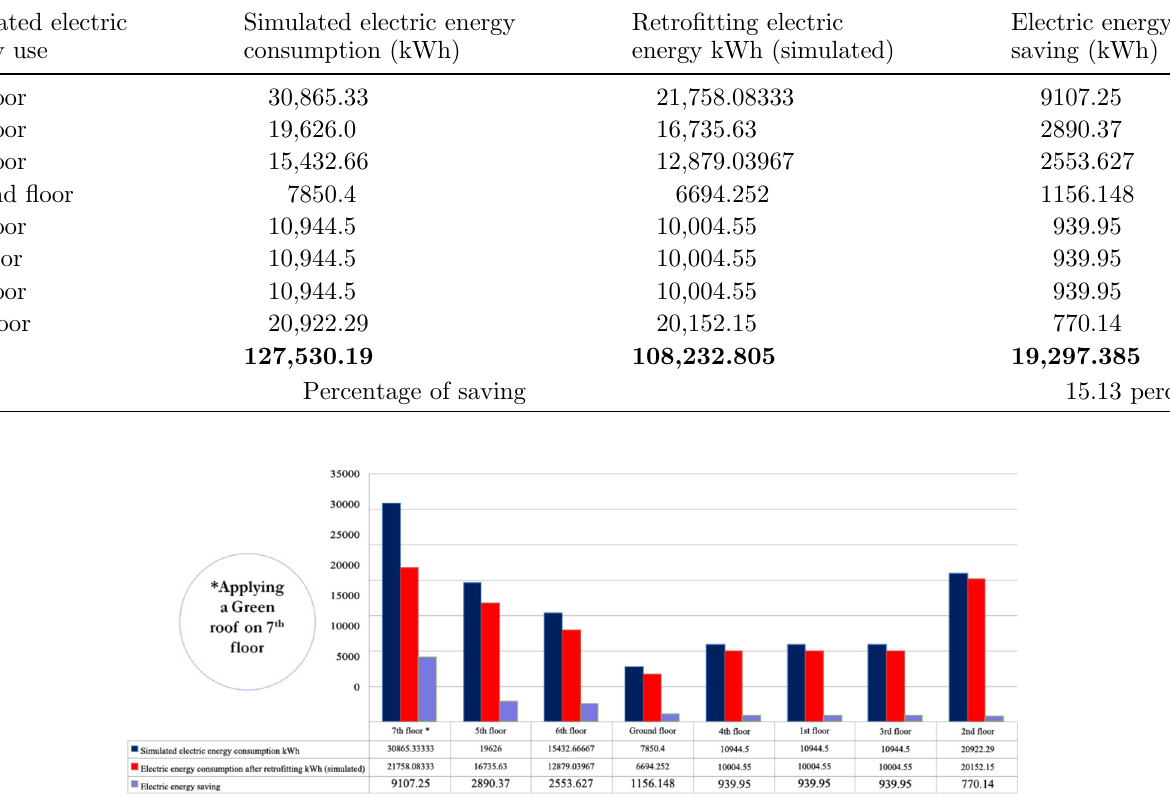
Fig. 8. Savings in energy use in all fl oors as a result of the retro fi tting